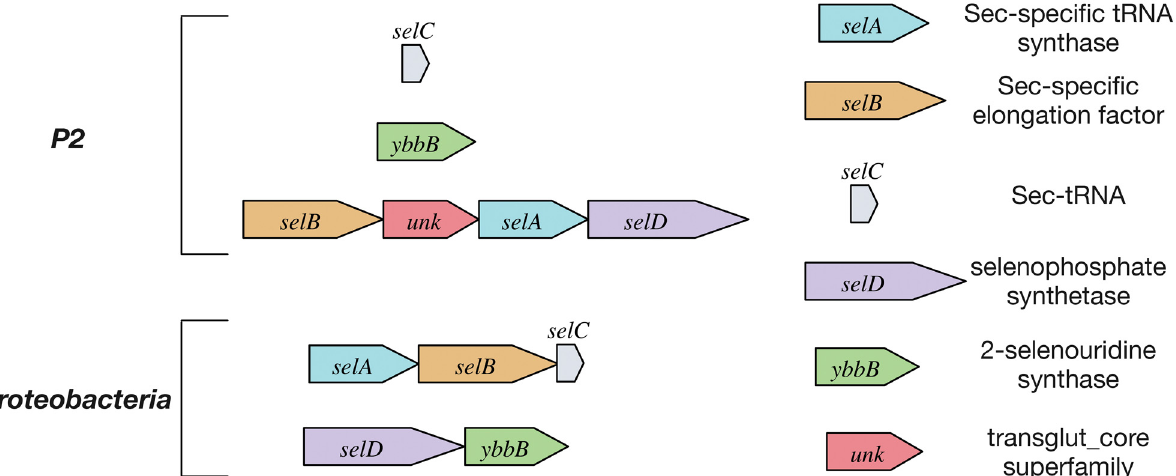
Fig 6. Comparison of operons encoding genes required for selenocysteine insertion and selenophosphate synthesis/utilization. For Proteobacteria, the two operons shown generally represent conserved structures for the majority of Sec-encoding and Sec-utilizing proteobacterial species. The Sec-insertion operon structure shown for P2 has not been found in other known genomes (NCBI), including P1. An additional gene is shown that contains a transglut_core domain (PFAM001841; likely to have cysteine protease function in prokaryotes).